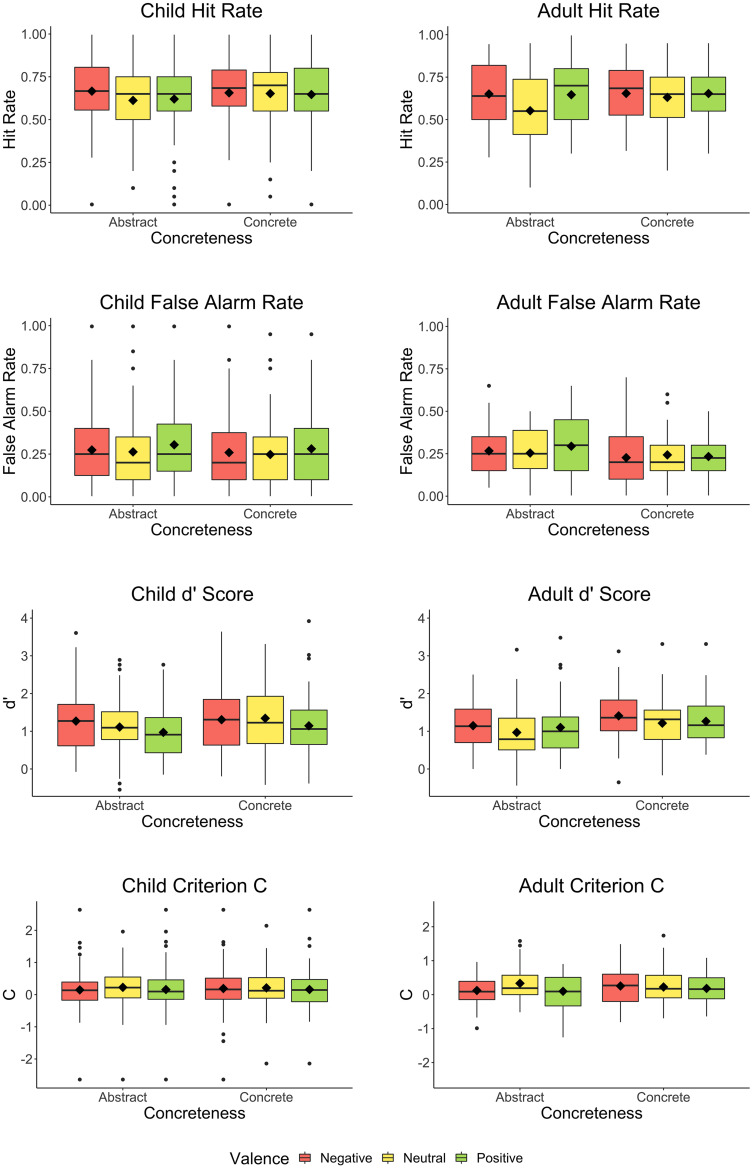
Children’s and adults’ hit rates, false alarm rates, d’ scores, and Criterion C values for words as a function of valence and concreteness. Horizontal bars indicate medians; diamonds indicate means. Colored boxes correspond to the range between the first and third quartiles (i.e., the 25th and 75th percentiles). Whiskers indicate the lowest and highest values up to 1.5 times the interquartile range from the first and third quartiles, respectively. Dots represent all other values beyond the whiskers.